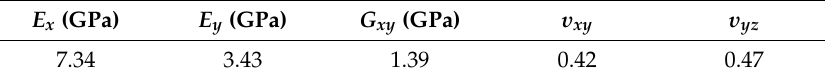
Table 3. Elastic properties from the extrudate swell region [25].